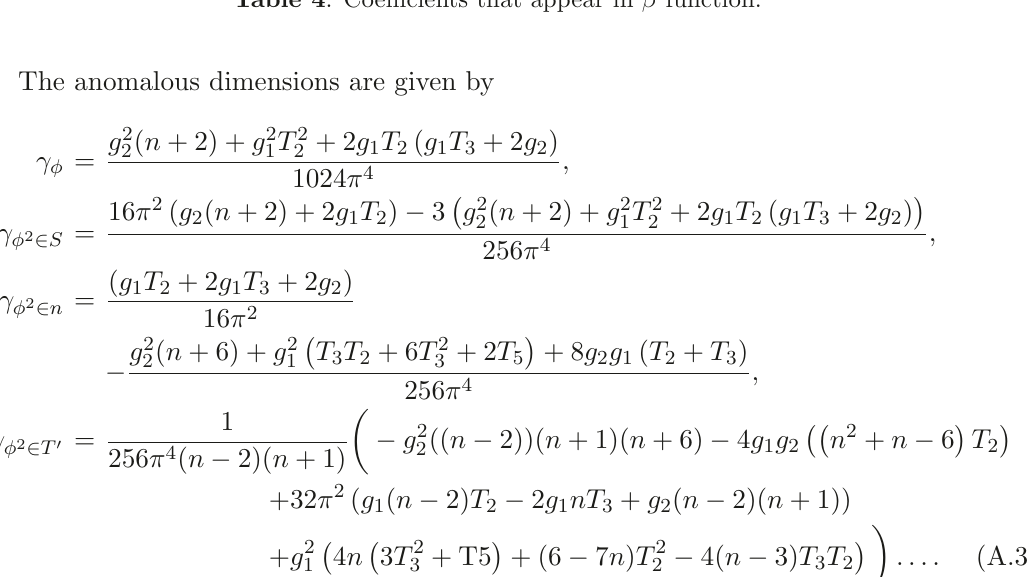
Table 4 . Coefficients that appear in β